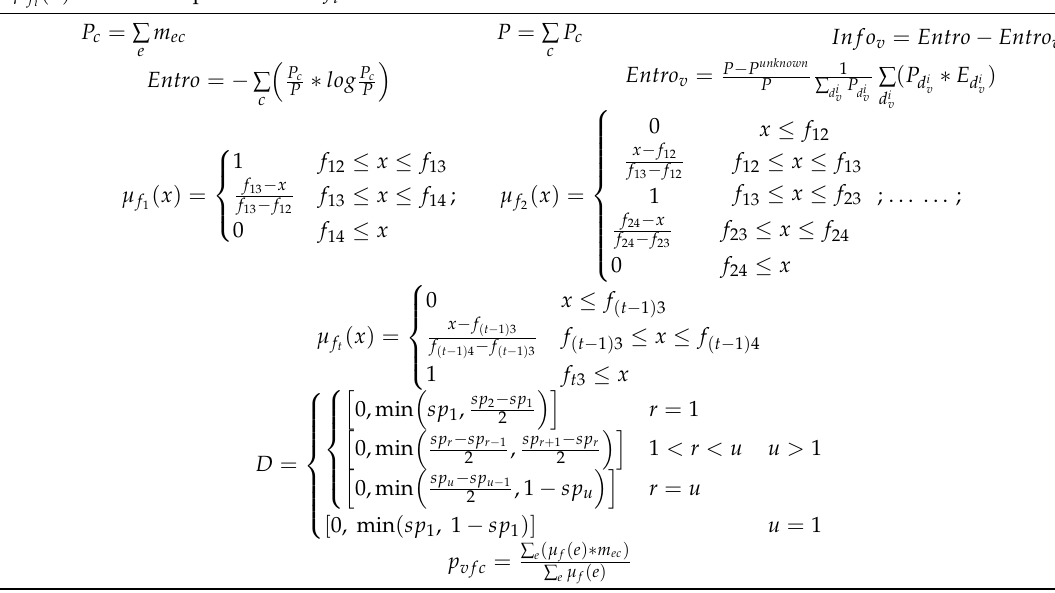
Table A5. Steps to train an RF